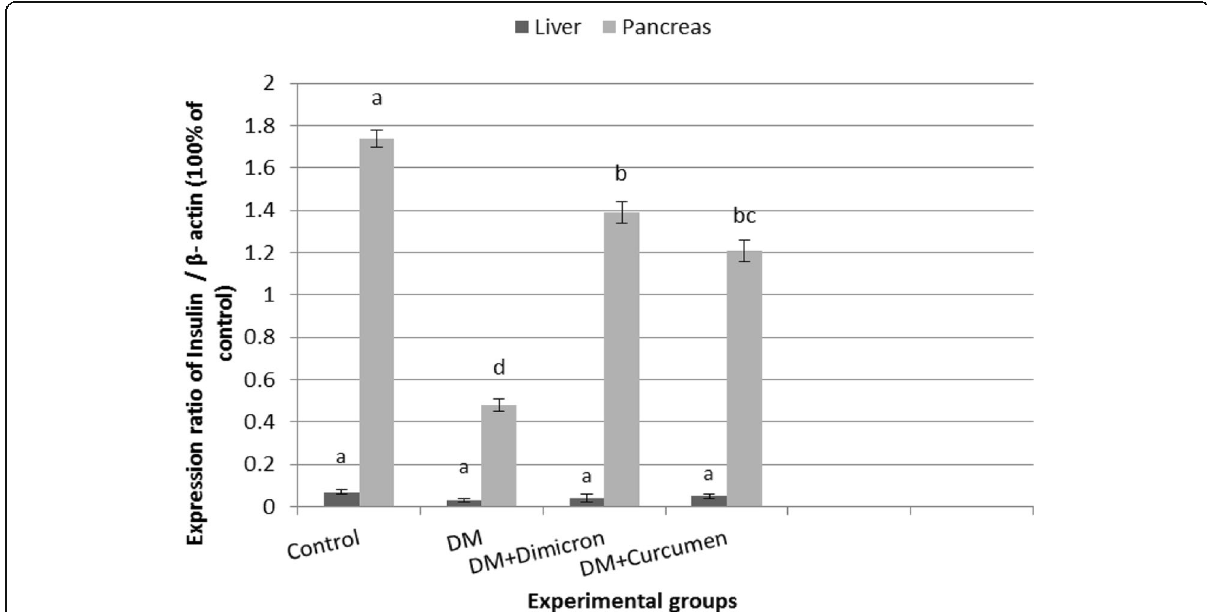
Fig. 5 The alterations of insulin-mRNA in liver and pancreas tissues collected from female DM rats treated with curcumin nanoparticles. a,b,c Mean values ± standard deviation within tissue with unlike superscript letters were significantly different ( P < 0.05)